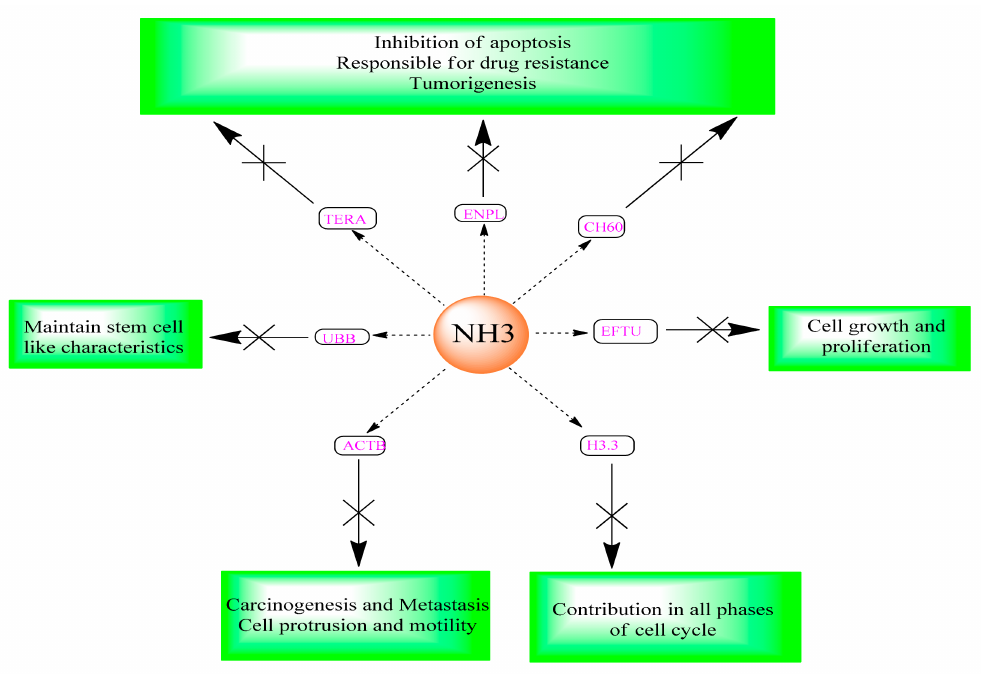
Figure 4. Anticancer mechanism of NH3 obtained from